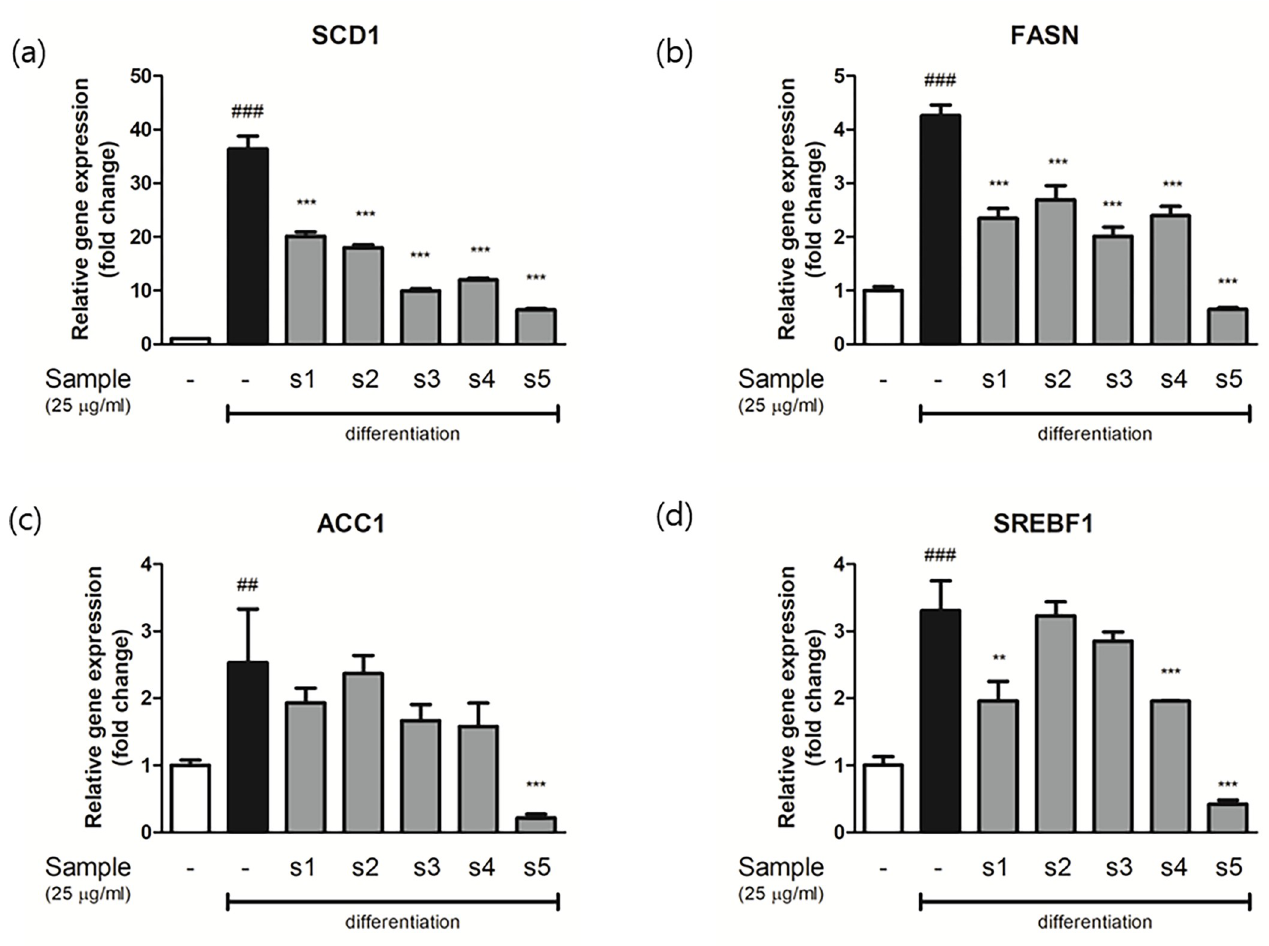
Fig 9. Relative gene expression levels of lipid synthesis markers were analyzed by real-time quantitative PCR in adipocytes. Real-time quantitative PCR results of (a) SCD1, (b) FASN, (c) ACC1, and (d) SREBF1. Relative gene expressions were calculated by dividing Ct values by that of β -actin. Results are presented as the means ± SD of three different experiments. ##P < 0.01 and ###P < 0.001 versus 3T3-L1 preadipocytes, �� P < 0.01, and ��� P < 0.001 versus differentiated adipocytes.